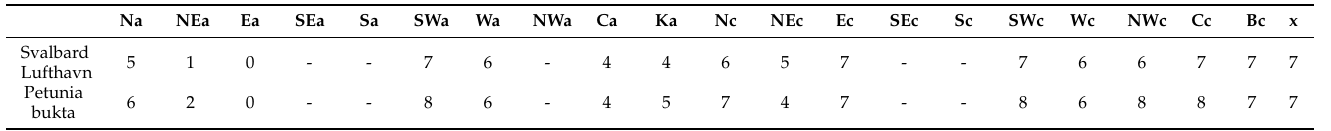
Table 4. Mean daily cloudiness (in oktas) in particular atmospheric circulation types by [23] in Svalbard-Lufthavn and Petuniabukta during the period from 9 July to 30 August 2016. Na NEa Svalbard Lufthavn